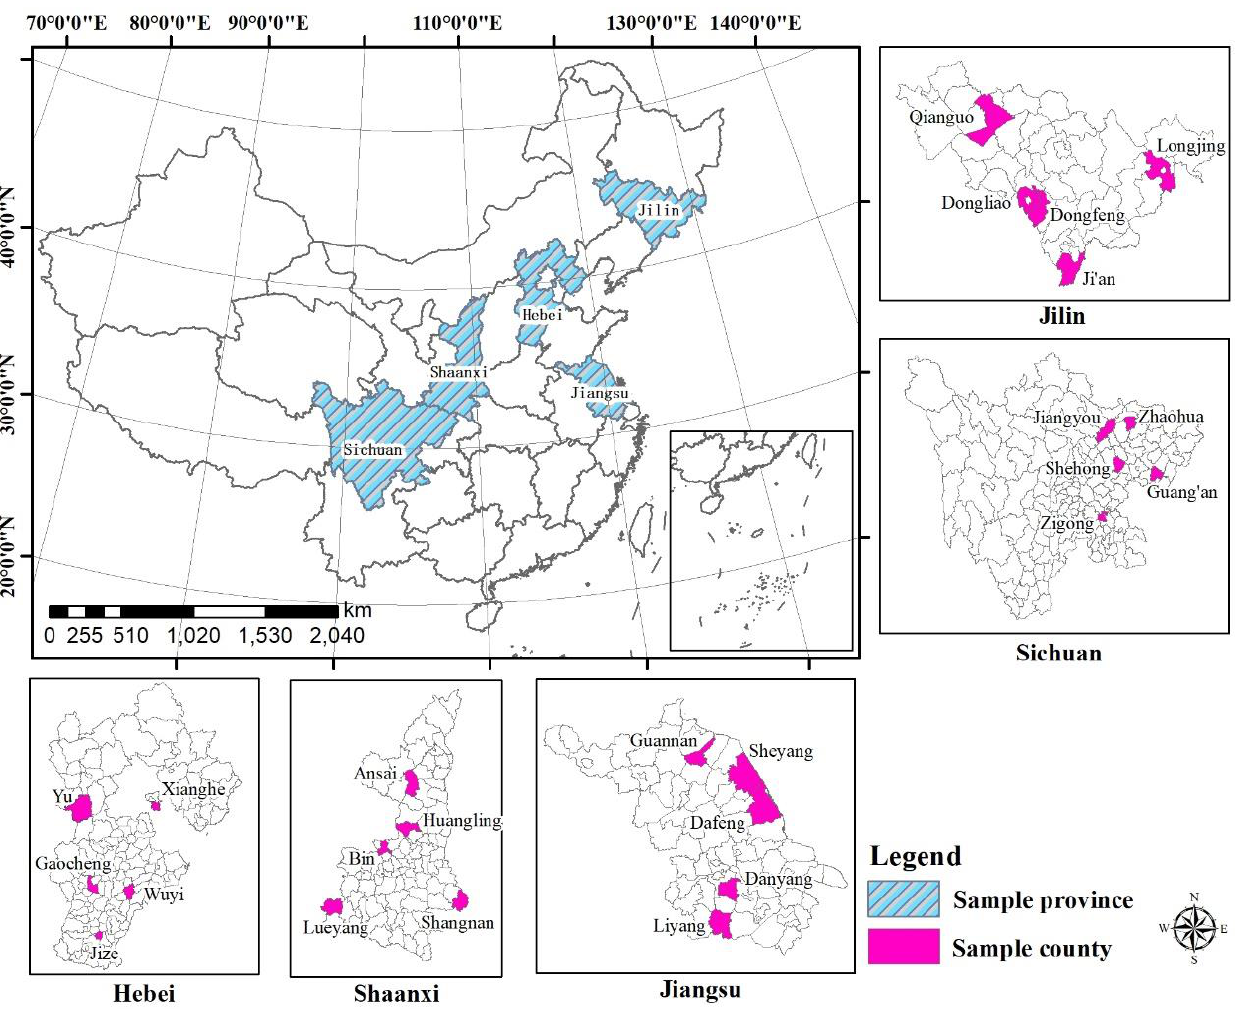
Figure 1. Map of sample province and counties’ distribution. Data source: China Rural Development Survey (CRDS).